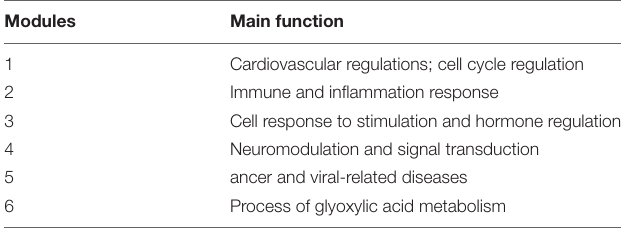
TABLE 1 | Main functions of six major